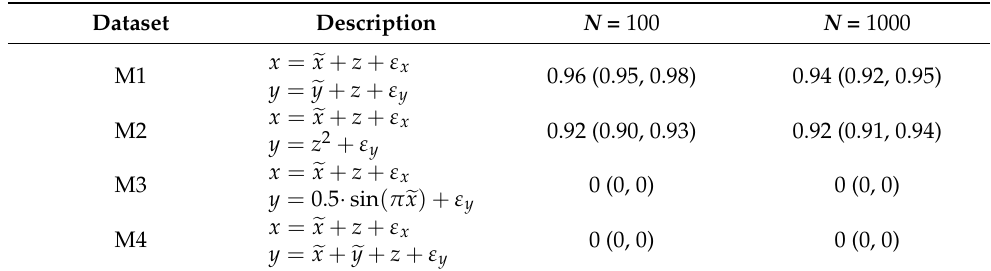
Table 2. Detection rates of conditional independence with